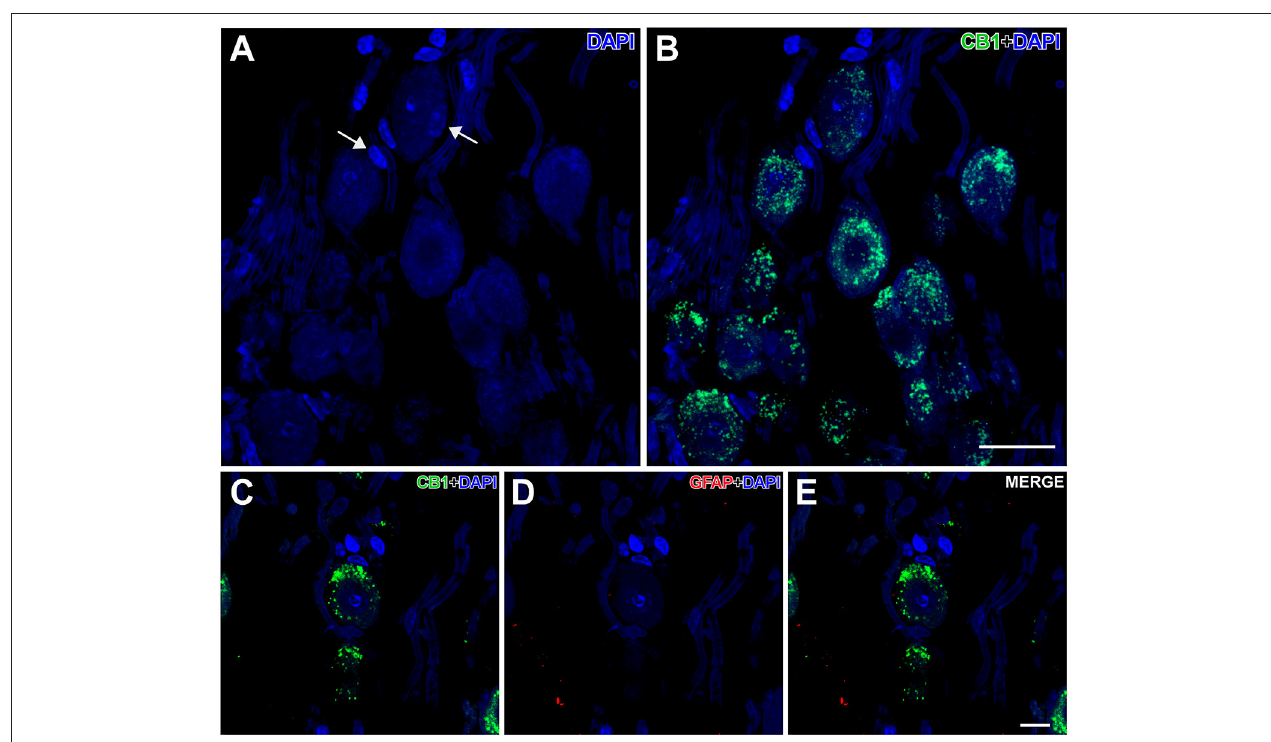
FIGURE 6 | Details of CB1- and GFAP-immunolabeling in the spiral cochlear ganglion of the GASH/Sal. (A,B) Low magnification confocal microscopy images show spiral ganglion neurons stained with DAPI (in blue) and CB1-immunolabeling (in green) in the spiral cochlear ganglion. Note that the perikaryon of the spiral ganglion neuron is enveloped by satellite cells (arrows). (C–E) High magnification confocal microscopy images show CB1-immunolabeling in the cell body of a spiral ganglion neuron. Weak GFAP-immunolabeling was observed in the spiral cochlear ganglion. Scale bars = 20 µ m in (A,B) ; 10 µ m in (C–E)